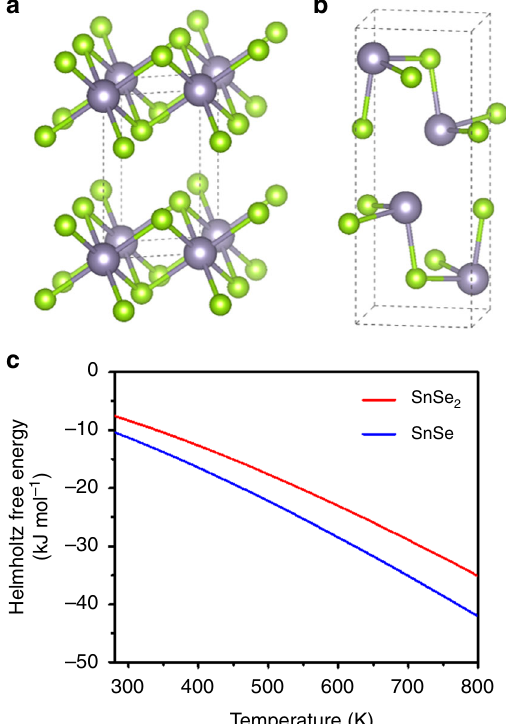
Fig. 4 Thermodynamic free energy calculation. The unit cell structures for calculation. Supercells for a SnSe 2 and b SnSe were expanded as much as 4× 3×2 and 2×2×2, respectively. c Helmholtz free energy of SnSe 2 and SnSe from fi rst-principle calculation, where SnSe is thermodynamically more stable compared to SnSe 2 in the entire temperature range from 300 to 800